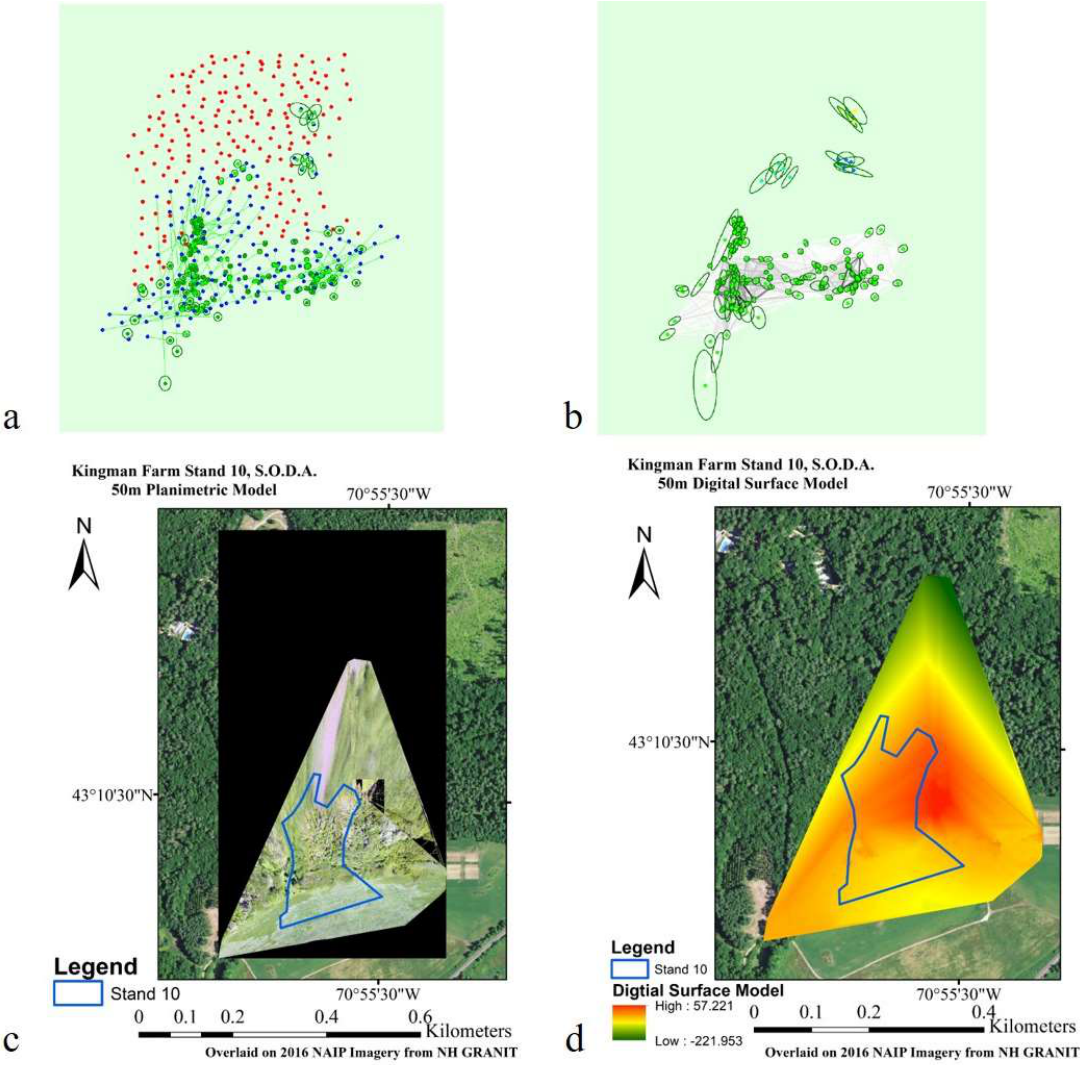
Figure 3. Pix4D mapper Pro initial processing results for the Sensor Optimized for Drone Applications (S.O.D.A) at a 50 m flying height above the canopy height model: ( a ) image alignment success (green), failure (red), and uncertainty (blue); ( b ) image-matching strength (weight of line network), and image geolocation error (circle area); ( c ) final planimetric product; and ( d ) representative digital surface model (DSM).